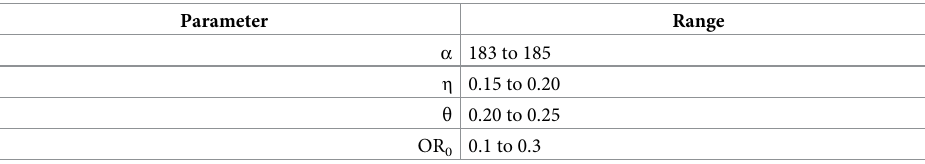
Table 3. Final calibration parameter